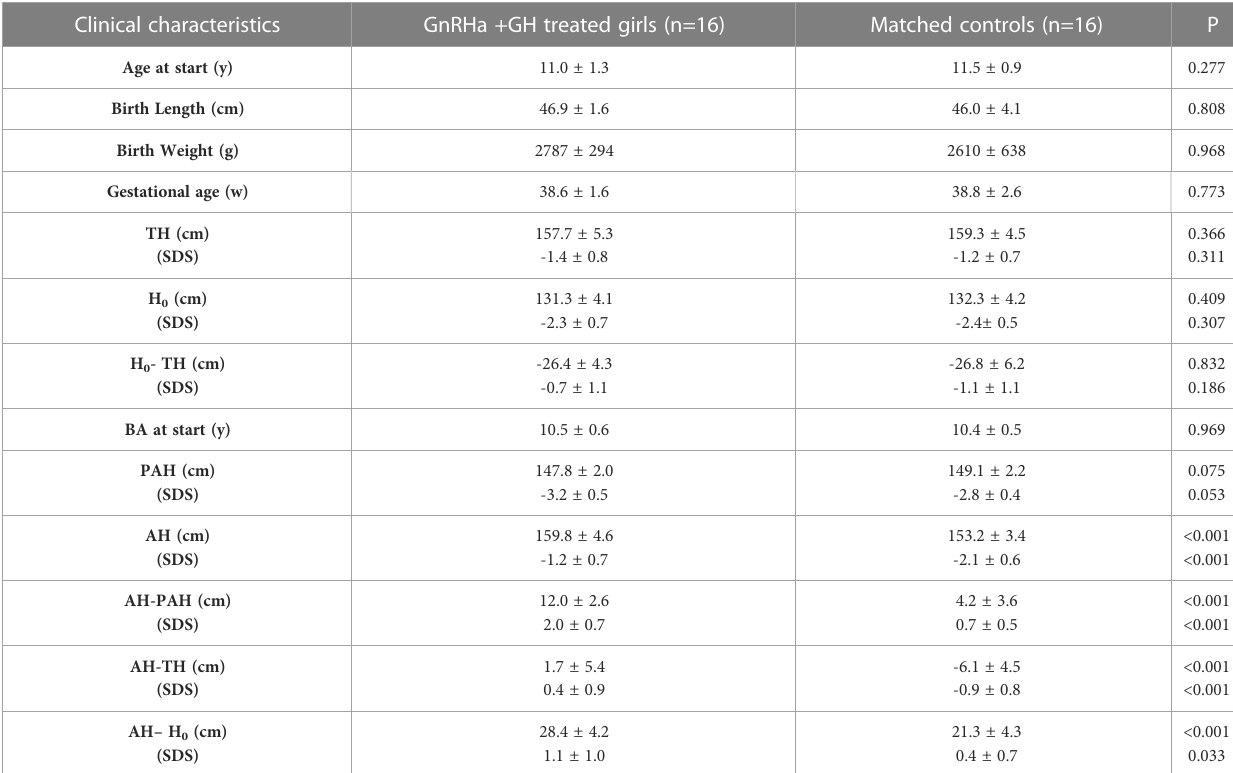
TABLE 2 Clinical characteristics and outcome parameters of treated girls in comparison to matched controls (mean ± SD). Clinical